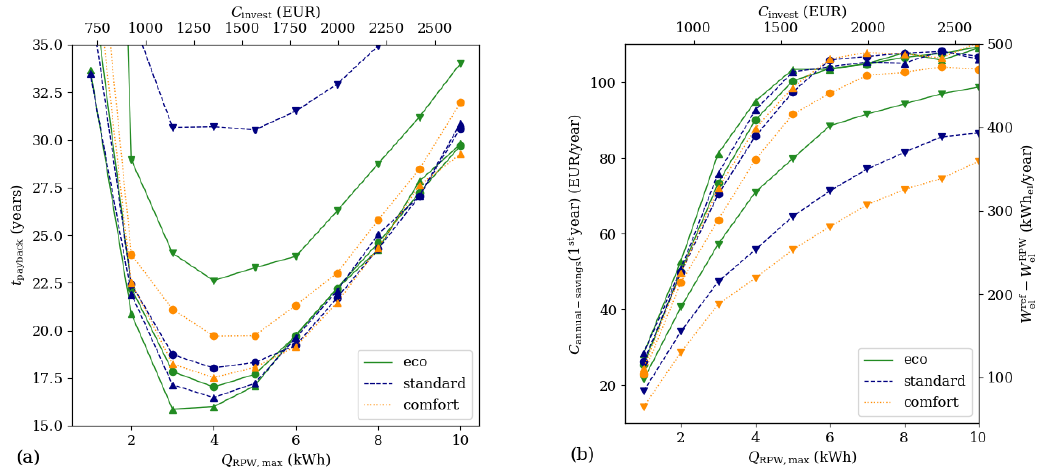
Figure 3. Payback time ( a ) and savings per year ( b ) for Case #2 (low-energy building located in Strasbourg). Markers “ ▼ ”, “●” and “ ▲ ” denote small (140 L), medium (210 L) and large (280 L) decentralized DHW storage devices. Please note that for the case with small decentralized storage devices operated in comfort mode, the payback time is higher than 35 years for all RPW-HEX storage sizes. Therefore, this case is not shown in ( a ).